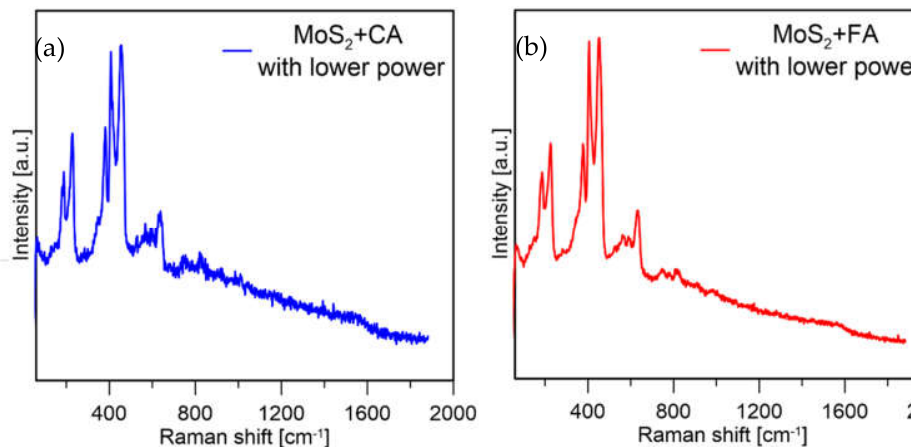
Figure 11. Raman spectra of MoS 2 prepared with ( a ) CA and ( b ) FA at 1% laser power.